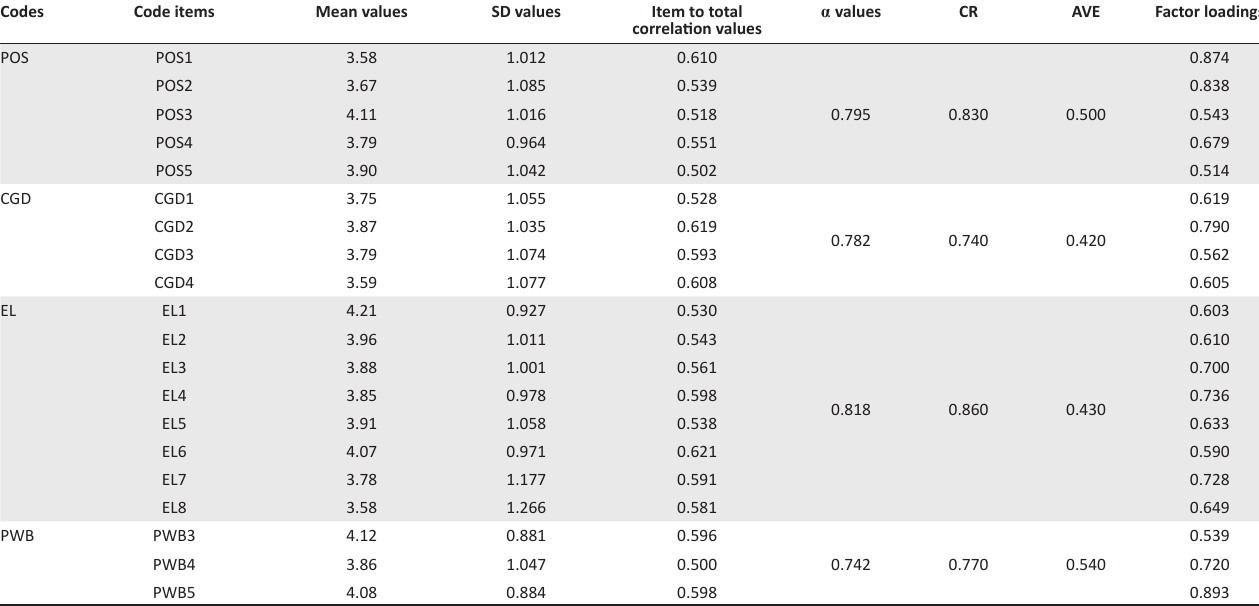
TABLE 2: Psychometric properties of measurement